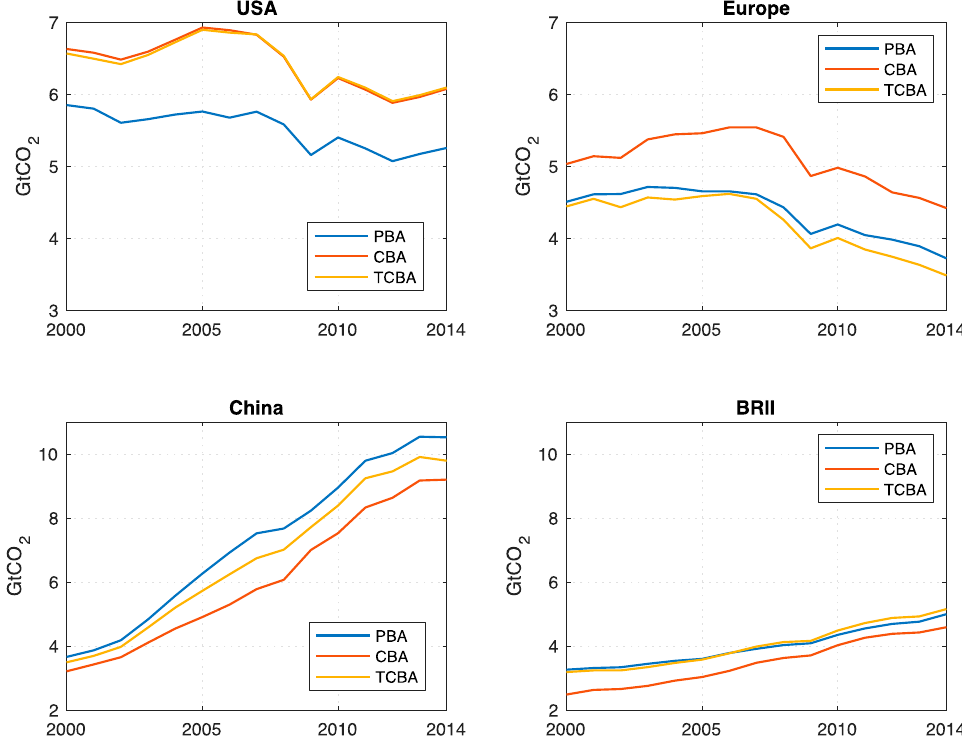
Figure 2. Development of PBA, CBA and TCBA 2000–2014 for the US, China, Europe (EU28 plus Norway and Switzerland), China and BRII countries (Brazil, Russia, India and